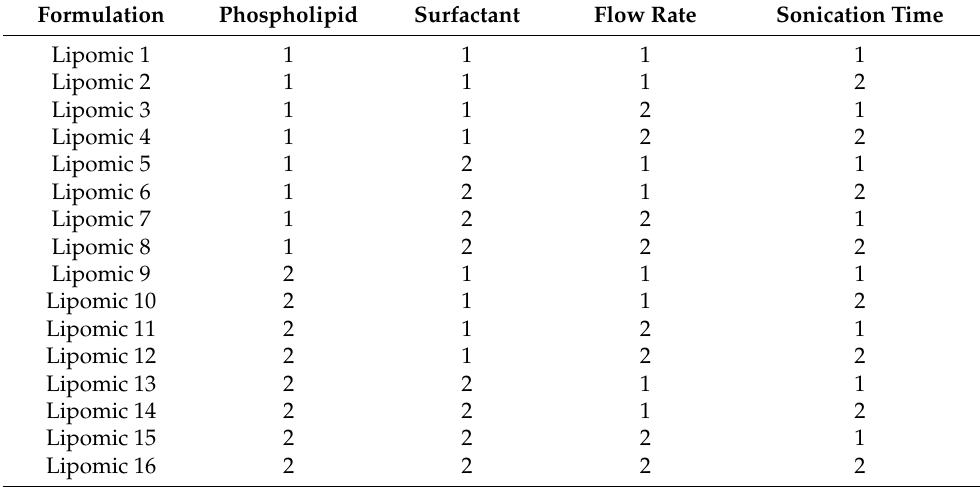
Table 5. Taguchi’s experimental